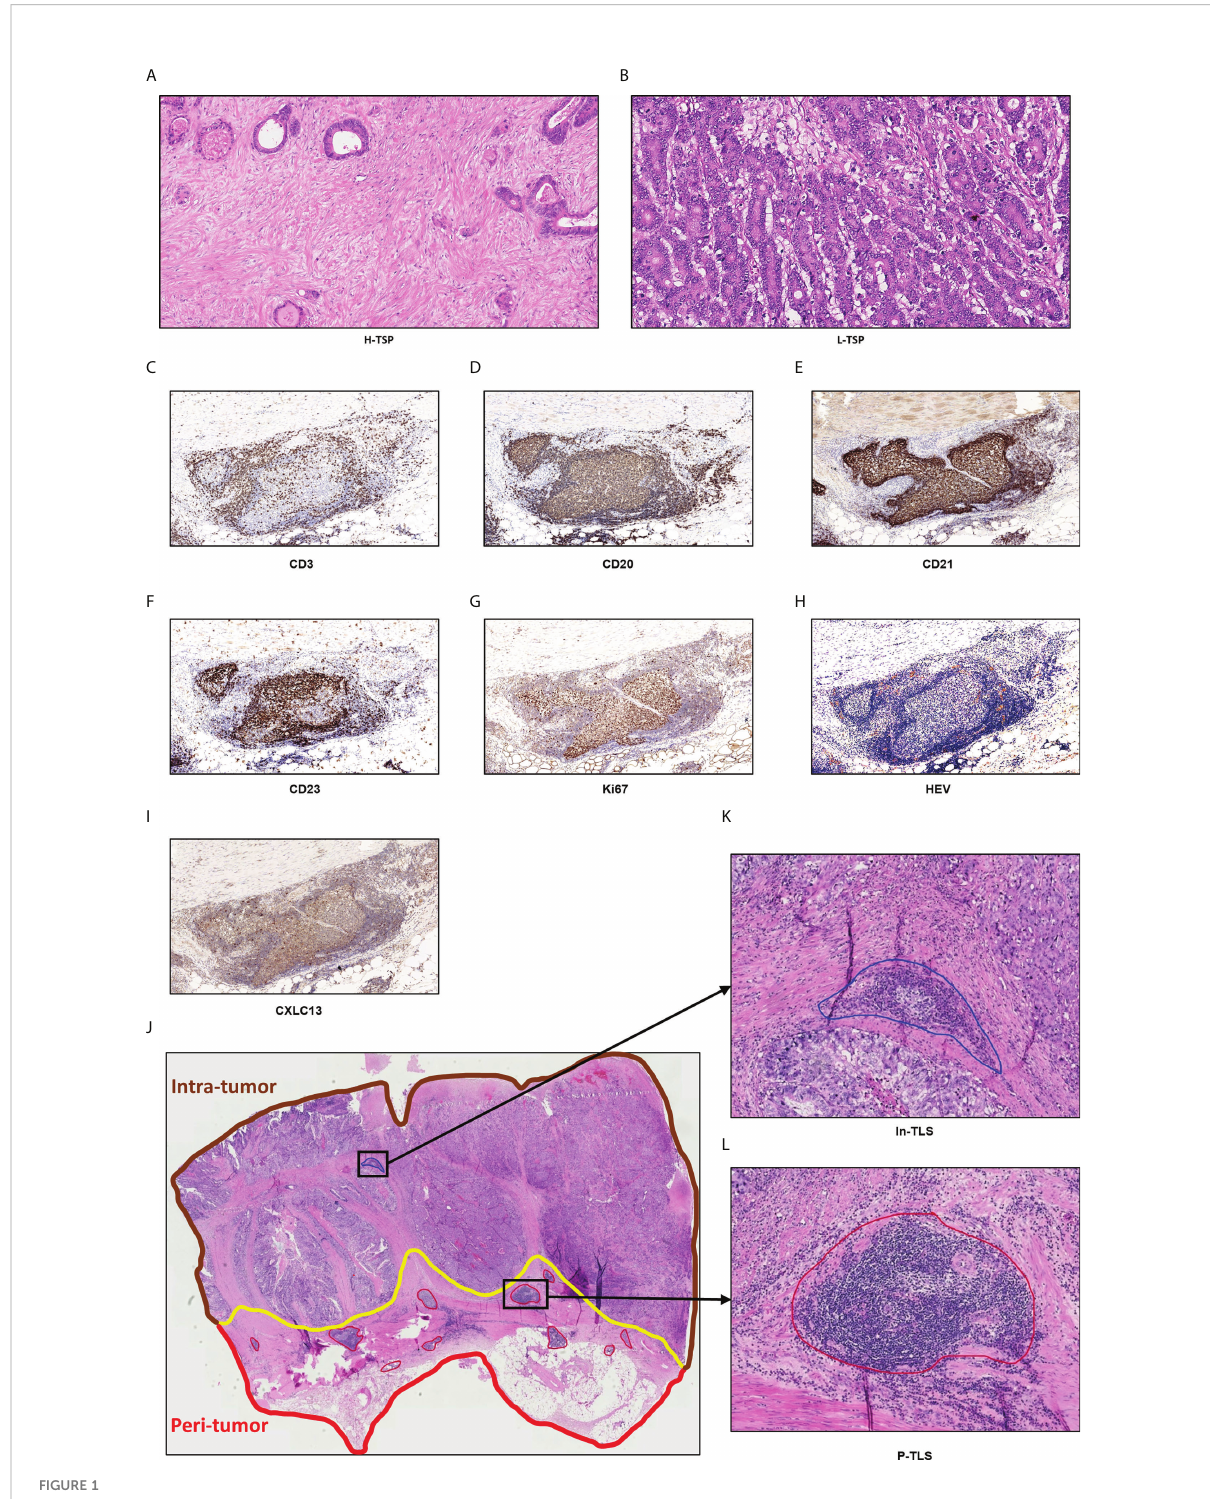
FIGURE 1 Hematoxylin and eosin-stained (H&E) sections of tumor stroma percentage and TLS. (A) High TSP (>50%). (B) Low TSP ( ≤ 50%). Germinal centers (GCs) were con fi rmed to contain strictly con fi ned regions of CD21 follicular dendritic cells in a fi eld of larger CD23 and Ki67 B cells (CD20) surrounded by PNAd vessels (C – I) . Peri-tumor region was surrounded in red while intra-tumor region was surrounded in brown (J) . In-TLS (K) and P-TLS (L) are highlighted in blue and red,